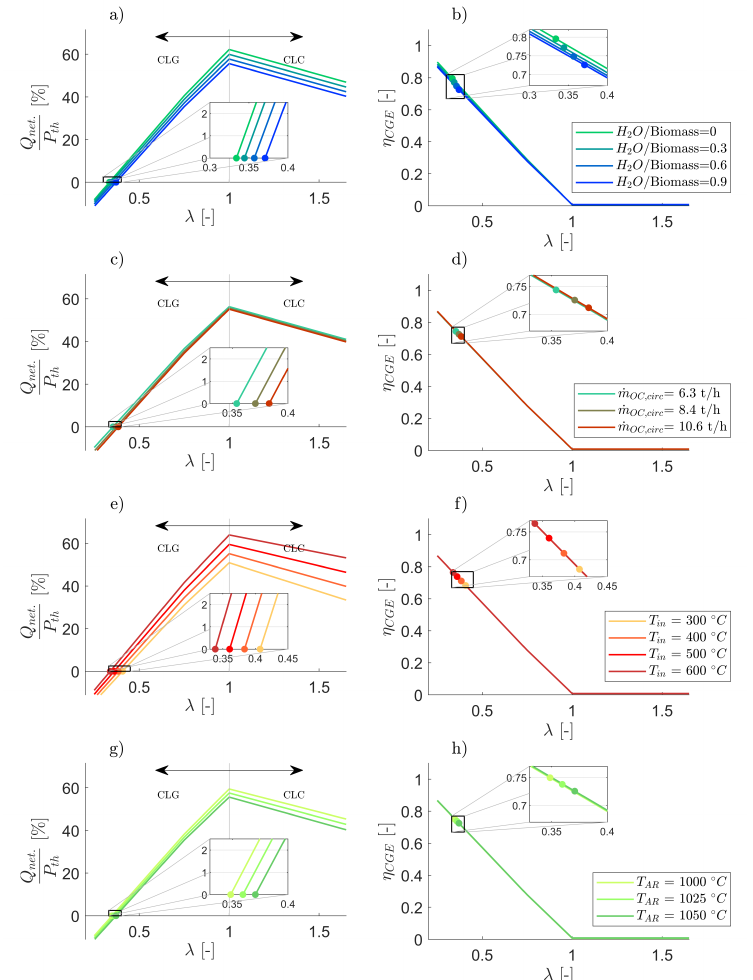
Figure 10. Net heat release and cold gas e ffi ciency for CLC / CLG process as a function of the air to fuel equivalence ratio for di ff erent steam to biomass ratios ( a , b ), OC circulation rates ( c , d ), gas inlet temperatures ( e , f ), and air reactor temperatures ( g , h ). Circles mark the cold gas e ffi ciency for . m OC = const ., so φ = λ for λ < 1 and φ = const . > 1 for λ > autothermal CLG operation (